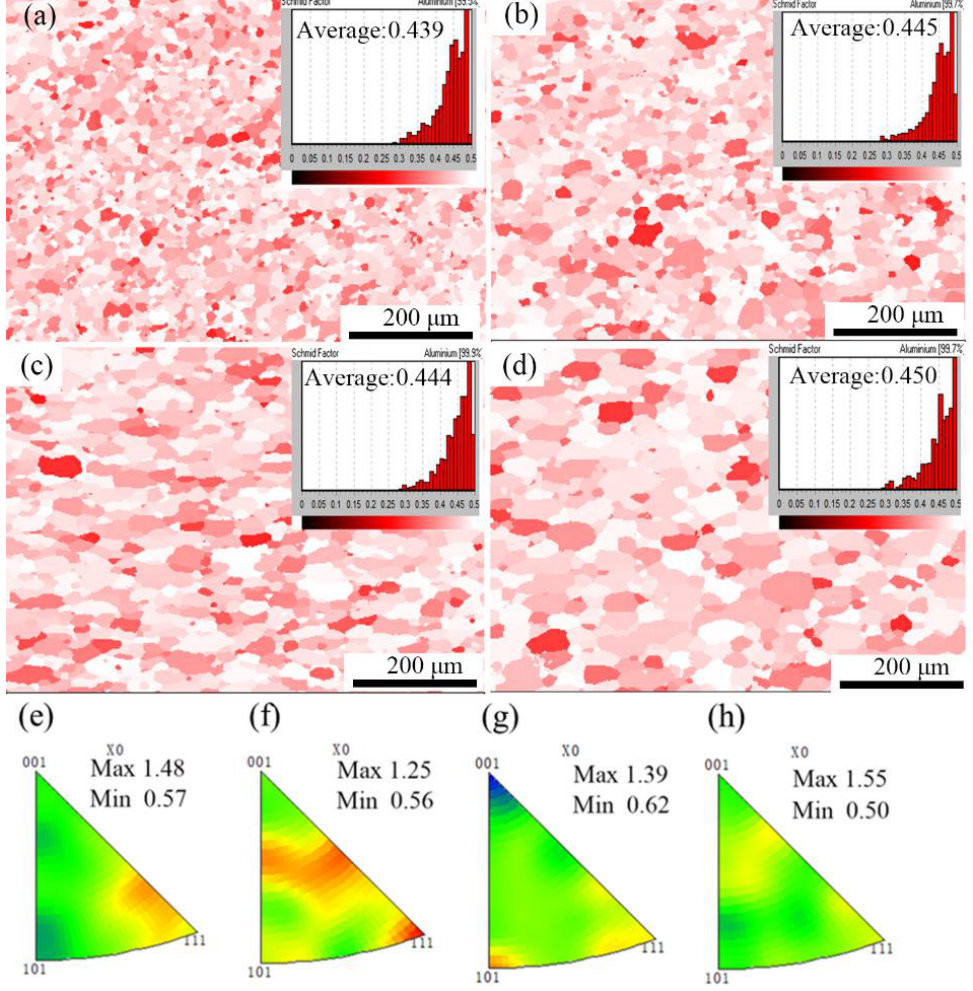
Figure 7. ( a – d ) Schmid factor map of the Al–Zn–Mg–Cu alloy deformed at different true strains with 0.41, 0.69, 1.61 and 2.17. ( e – h ) Inverse pole figure and texture intensity during superplastic deformation with strains of 0.41, 0.69, 1.61 and 2.17.